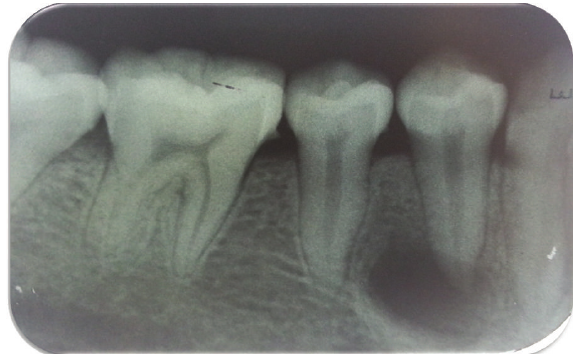
Figure 2: Diagnostic IOPAR, periapical radiolucency with respect to 44.